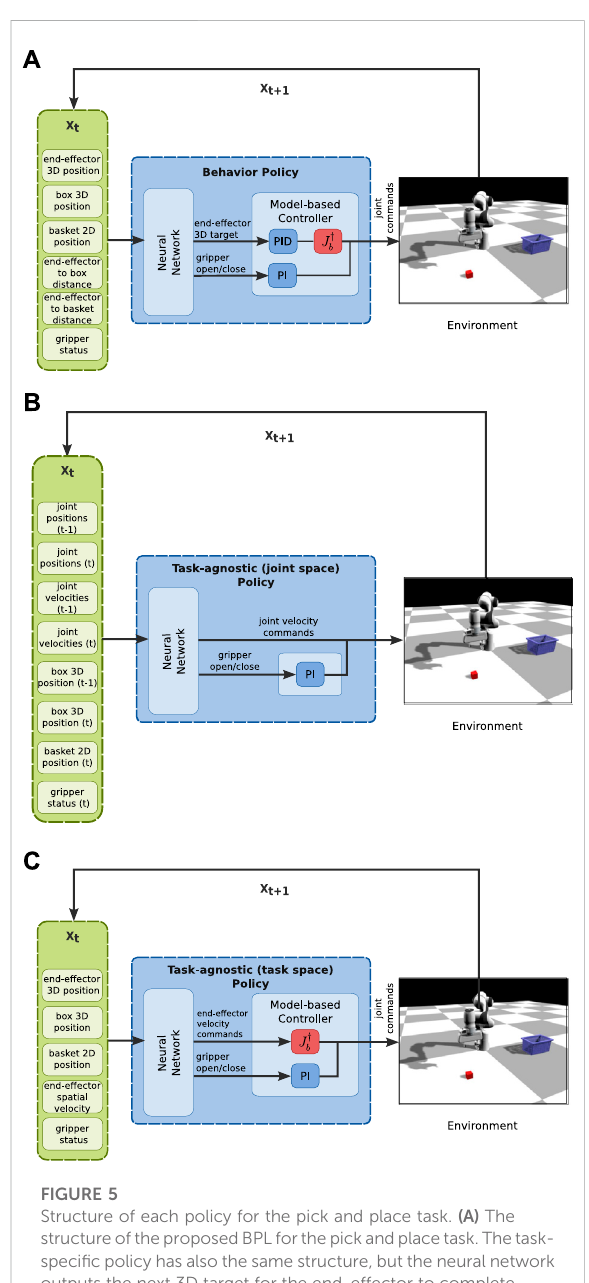
FIGURE 5 Structure of each policy for the pick and place task. (A) The structureoftheproposedBPLforthepickandplacetask.Thetask- speci fi c policy has also the same structure, but the neural network outputs the next 3D target for the end-effector to complete the current stage of the task as provided by the FSM. (B) The structureofthetask-agnostic(jointspace)policy. (C) Thestructure of task-agnostic (task space)